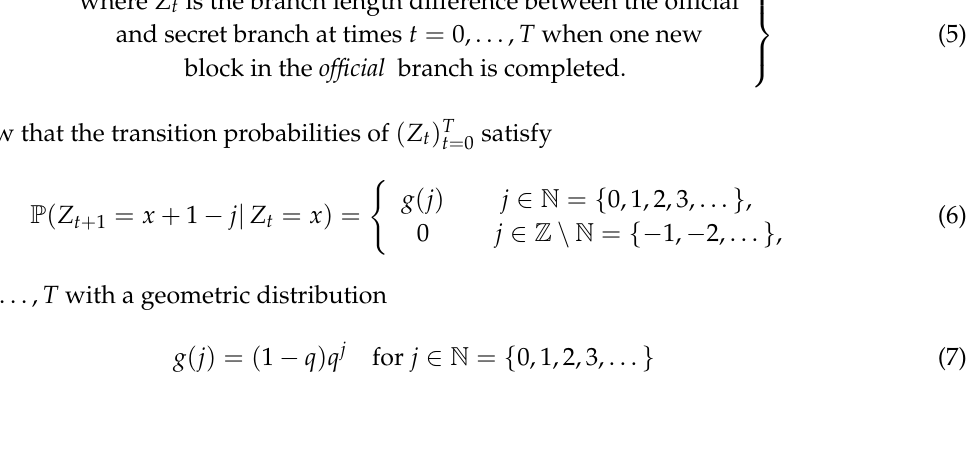
[ 0, 1 ] calculated by (3) with k = 0 (solid line) versus k = 10 ∈